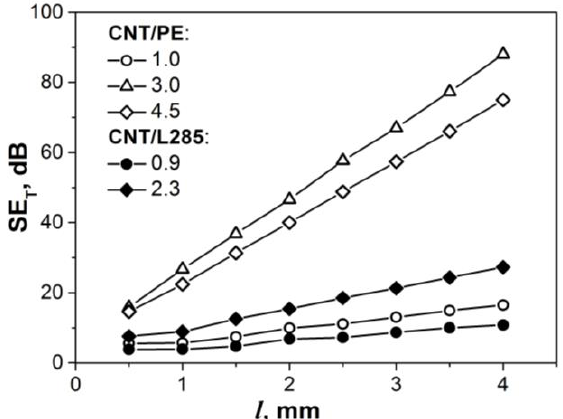
Figure 8. EMR shielding efficiency 𝑆𝐸 𝑇 versus sample thickness l for segregated and random CNT-based composites at the fixed frequency 50 GHz.